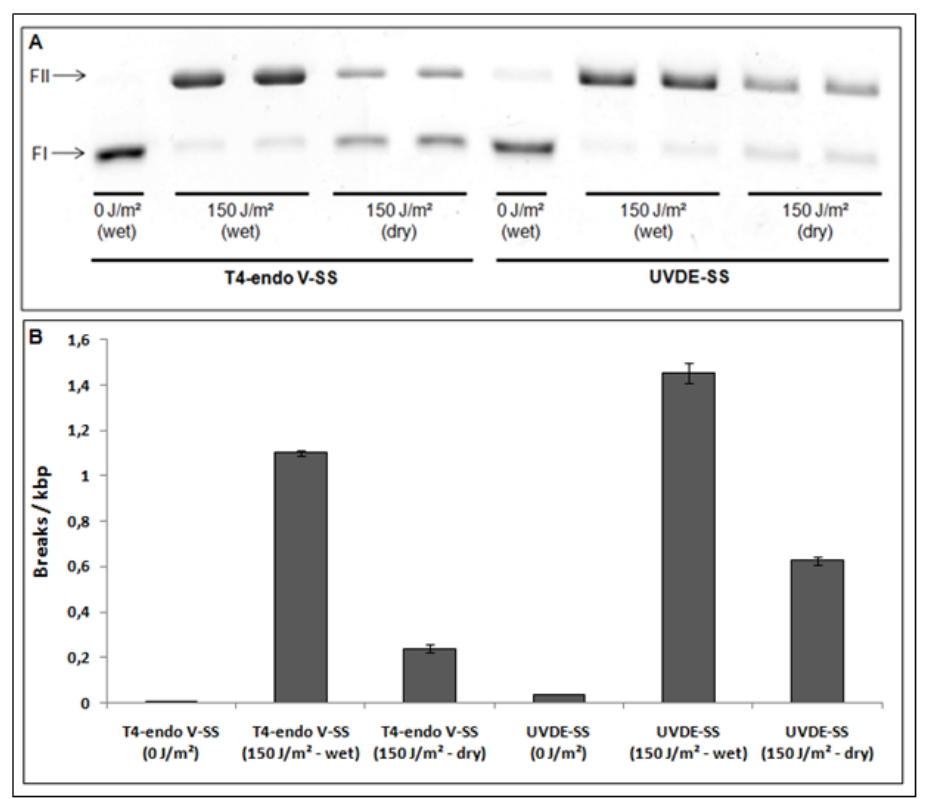
Figure 5. Analysis of UVC-induced DNA lesions induced in DNA in a buffer or under dry conditions. ( A ) Representative example of DNA photolesion induction after DNA exposure to UVC radiation. Plasmid DNA samples were UVC-exposed either diluted in a TE buffer (wet) or dried on a glass surface (dry) at room temperature and atmospheric pressure. 200 ng of both recovered DNA samples were treated with T4-endo V and UVDE enzymes. FI indicates the supercoiled DNA form and FII the relaxed DNA form resulting from enzymatic cleavage of DNA photoproducts. ( B ) Quantification of DNA photoproducts after UVC lamp exposure. T4-endo V-SS—T4-endonuclease V sensitive sites; UVDE-SS—Ultraviolet Damage Endonuclease sensitive sites (for details of the methodology employed the reader should refer to